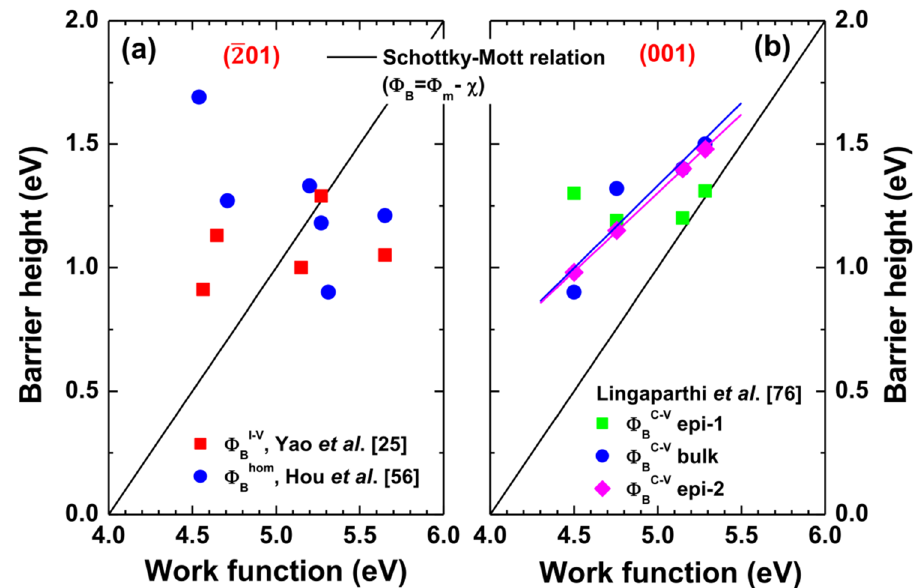
Fig. 3 Plots of barrier height versus metal work function for a ( 2 01) β -Ga O Schottky con- 2 3 tacts using the barrier heights taken from Yao et al. [25] and Hou et al. [56] and b (001) β -Ga O Schottky contacts 2 3 using the barrier heights taken from Lingaparthi et al. [76]. The metal work functions were taken from ref.